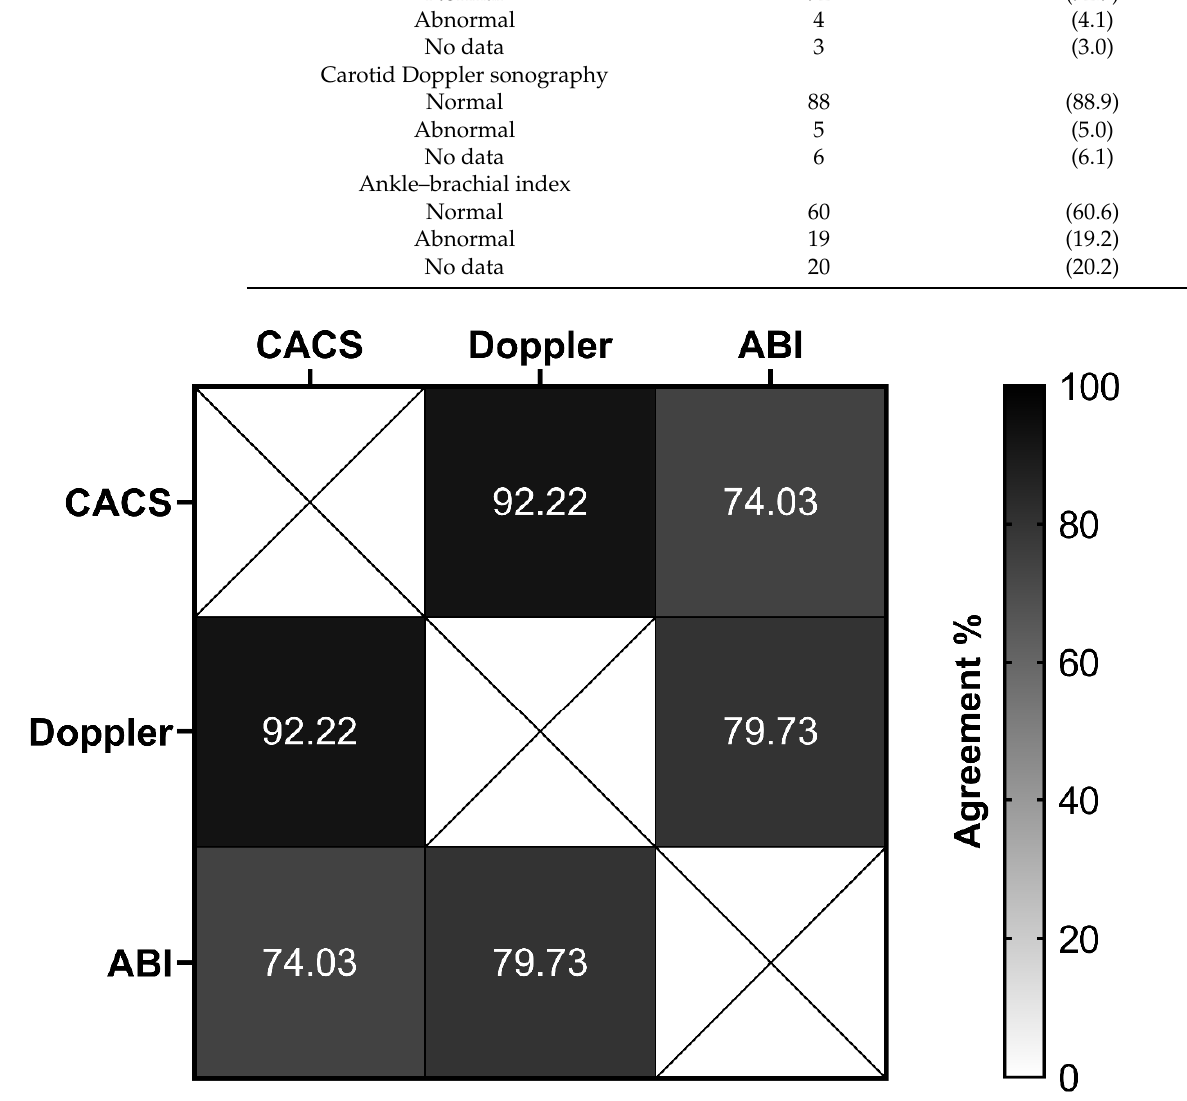
Figure 1. The overall percentage of agreement between different methods to evaluate early markers of cardiovascular disease in type 1 diabetes patients. CACS, coronary artery calcium score (normal versus abnormal); Doppler, carotid Doppler sonography (normal versus abnormal); ABI, ankle– brachial index (normal versus abnormal).